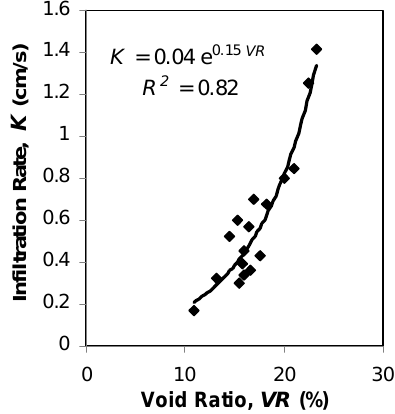
Figure 4. Relationship between void ratio and infiltration rate of PCPC